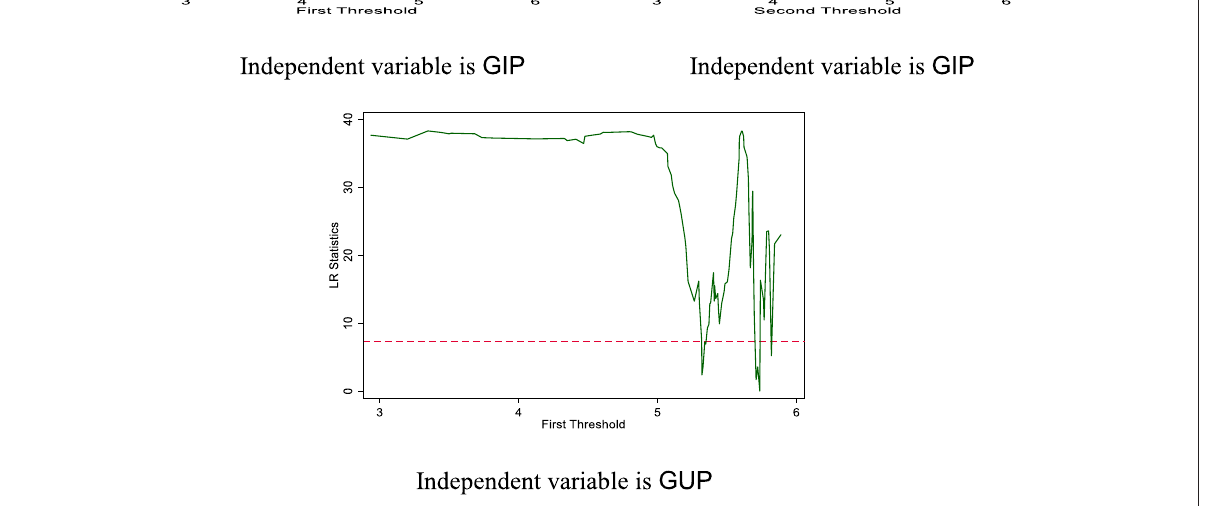
FIGURE 5 | Threshold values of different independent